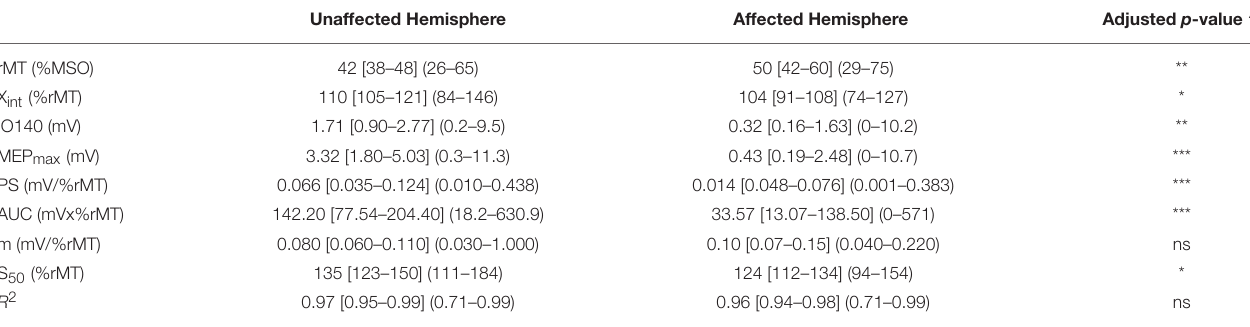
TABLE 3 | Electrophysiological parameters in stroke